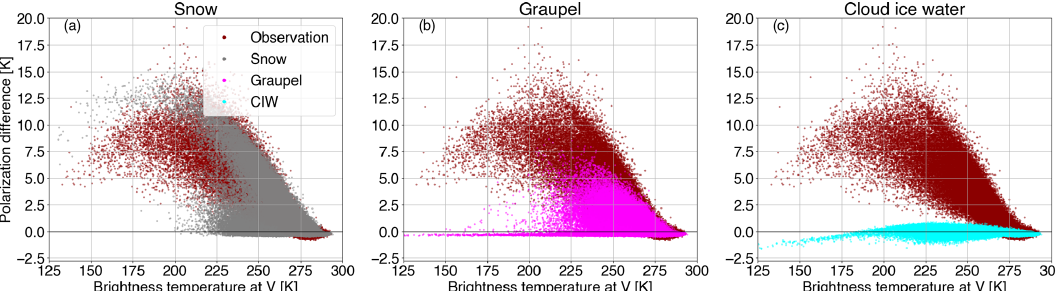
Figure 6. As in Fig. 2 but for (a) snow (gray), (b) graupel (magenta), and (c) cloud ice water (CIW; cyan) individually polarized passive monitoring experiments at a polarization ratio of 1.4.